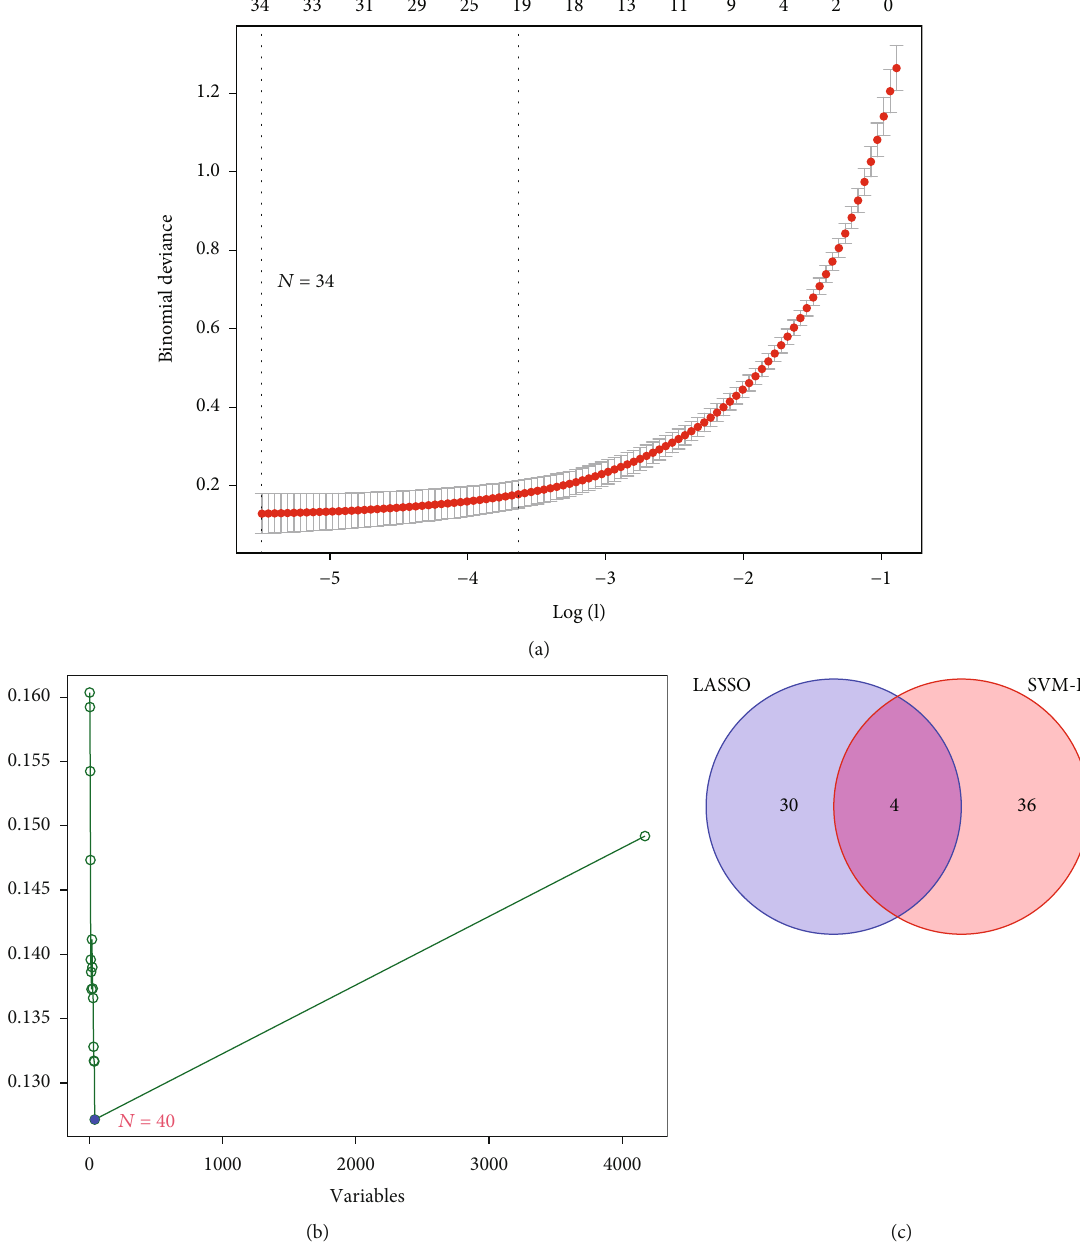
Figure 3: Screening process of diagnostic biomarker candidates for Kawasaki disease diagnosis. (a) Tuning feature selection in the least absolute shrinkage and selection operator model. (b) A plot of biomarkers selection via support vector machine-recursive feature elimination (SVM-RFE) algorithm. (c) Venn diagram demonstrating four diagnostic markers shared by the least absolute shrinkage and selection operator and SVM-RFE